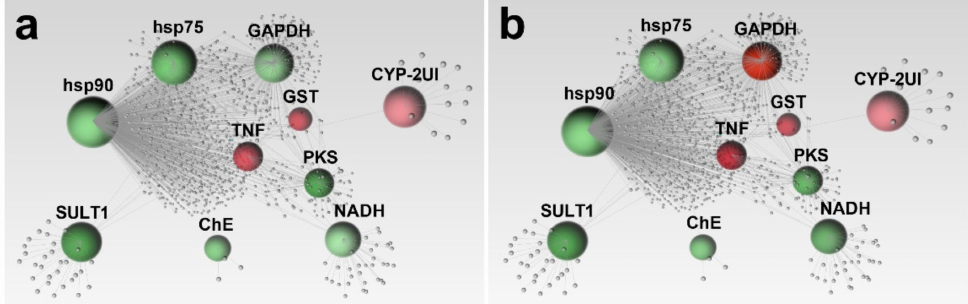
Figure 2. Gene networks obtained by STRING interactome analysis of ten genes involved in stress response and detoxification. Correlation confidence score cut-off of 400 was reported. Among functionally correlated genes, those with up (red) and down (green) expression affected by PAHs ( a ) and PCBs ( b ) were reported. Color shading depends on fold-change values. Gray spheres represent additional connections. The list of human orthologous genes used for Network analysis is reported in Supplementary Table